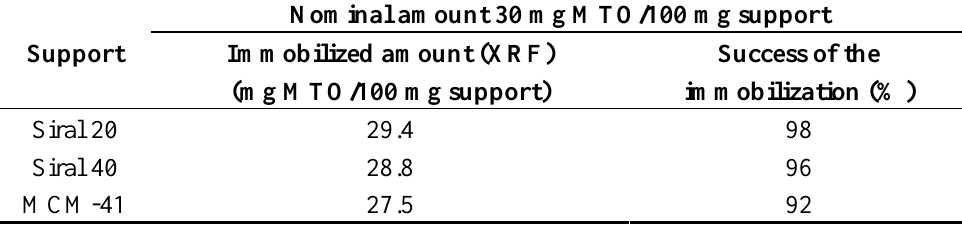
Table 2. Immobilized amount of MTO on supports after immobilization by 30 mg of MTO on 100 mg of support (determined by XRF